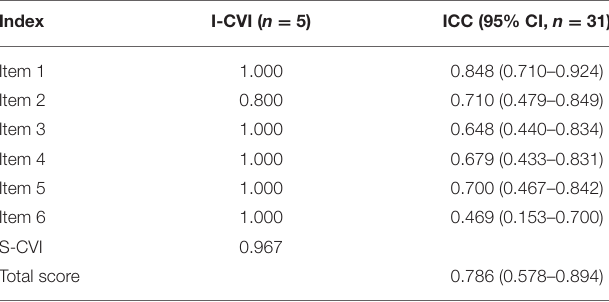
TABLE 2 | Intraclass correlation coefficient (ICC) of freezing of gait questionnaire, Chinese language version